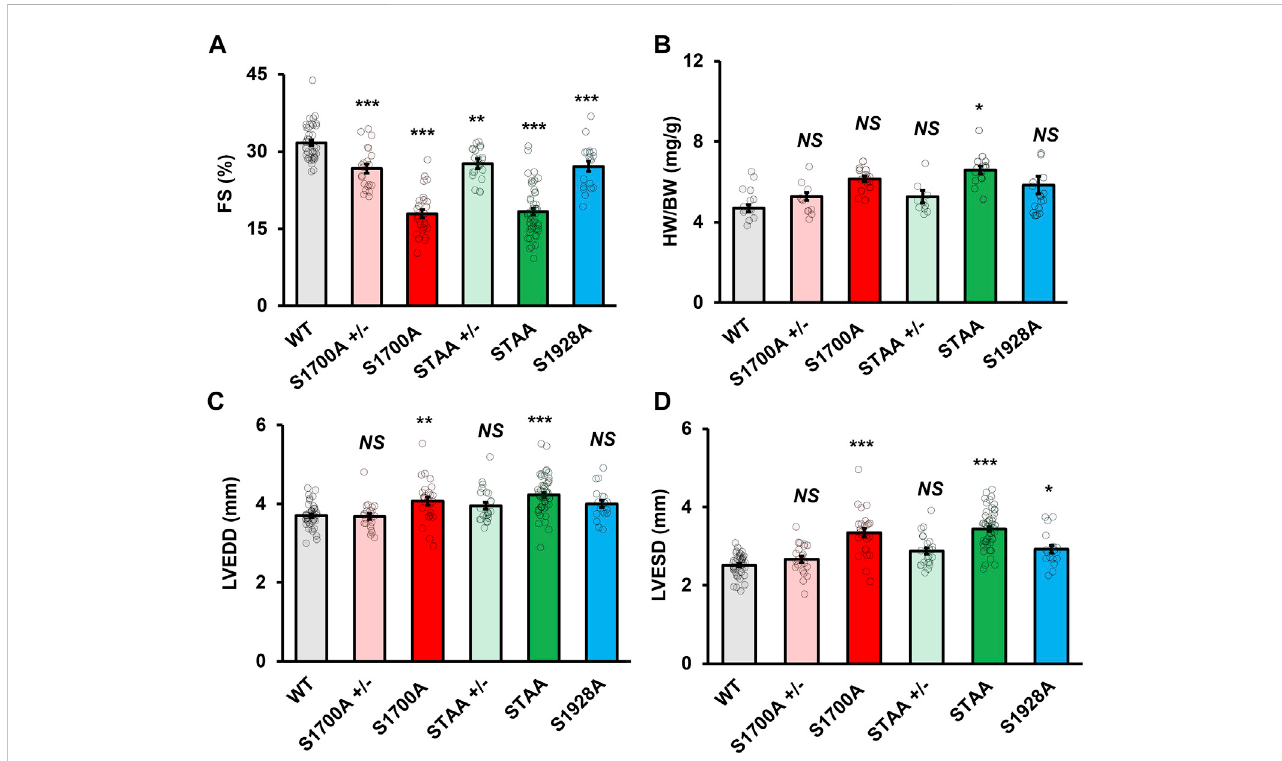
FIGURE 1 Impaired baseline systolic function in mice with heterozygous and homozygous Ca V 1.2 phosphoregulatory site mutations. Left-ventricular (A) fractional shortening, (B) heart weight, (C) end-diastolic diameter and (D) end-systolic diameter in young WT, heterozygous and homozygous S1700A and STAA mice, and homozygousS1928A mice. Statisticalsigni fi cance determined via ANOVA andpost-hocTukeyHSD comparison to WT.Error barsare S.E.M.; N = 41 (WT), 28 (S1700A), 53 (STAA), 19 (S1928A), 23 (STAA +/ − ), 21 (S1700A +/ − ); * p < 0.05, ** p < 0.01, *** p <